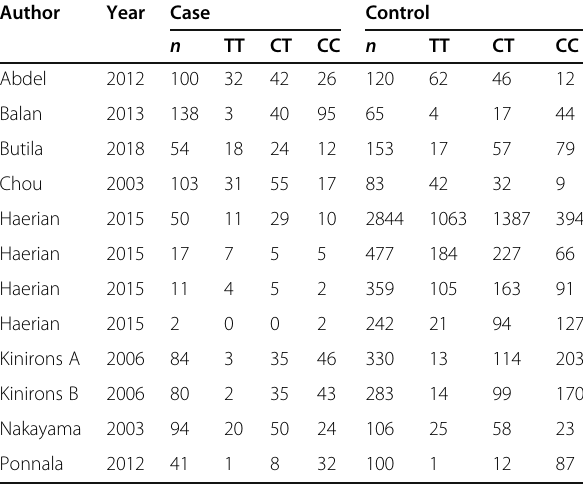
Table 2 Genotypes of GABRG2 rs211037 polymorphism